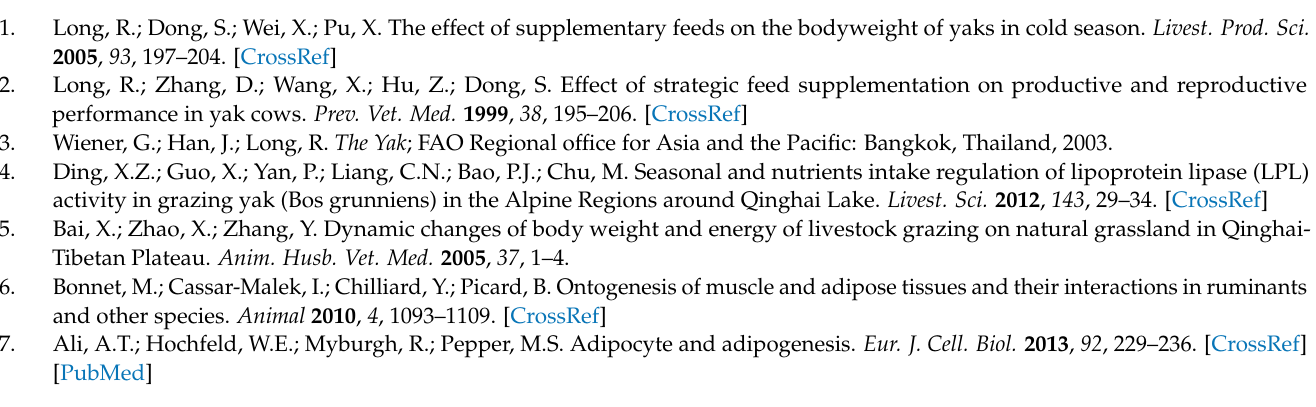
reverse. Figure S1: The western blot original image included PPAR γ and